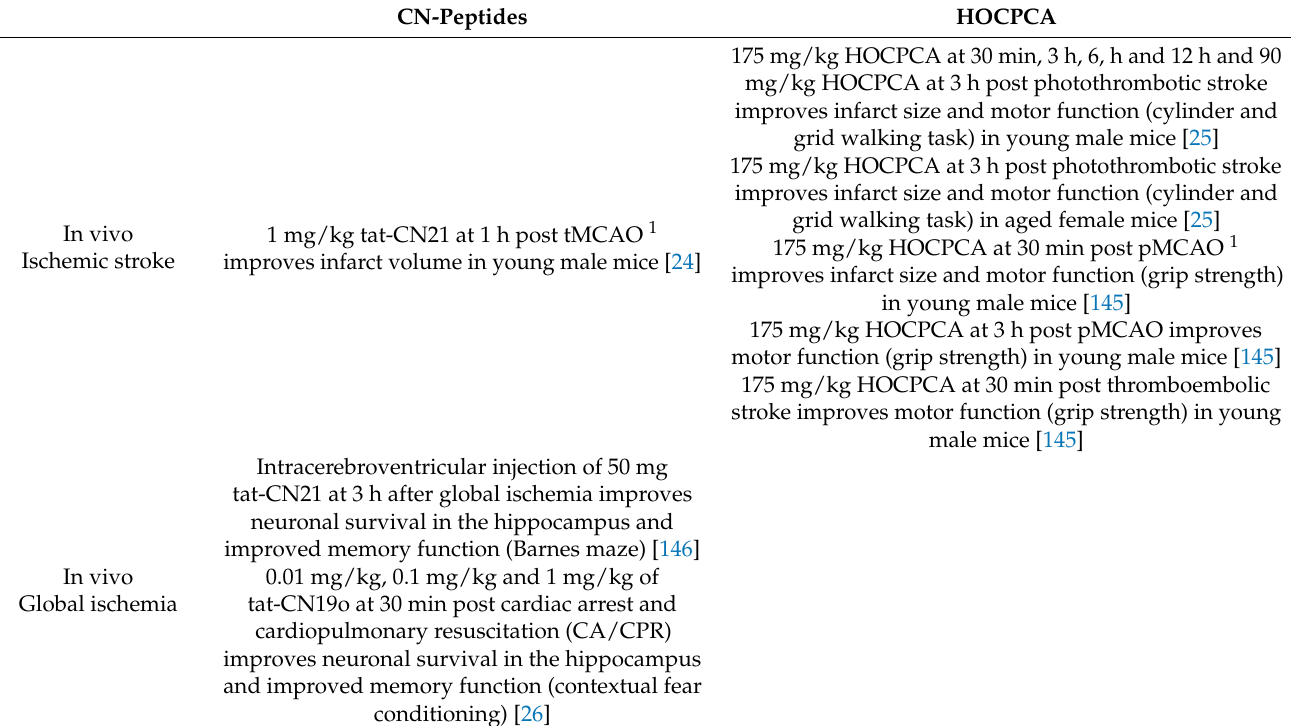
Table 1. Summary of in vivo neuroprotective effects of the Tat peptide CN21 and CN19o as well as the GHB analogue 3-hydroxycyclopent-1-enecarboxylic acid (HOCPCA). Of note, CN-peptides are administered intravenously and HOCPCA intraperitoneally